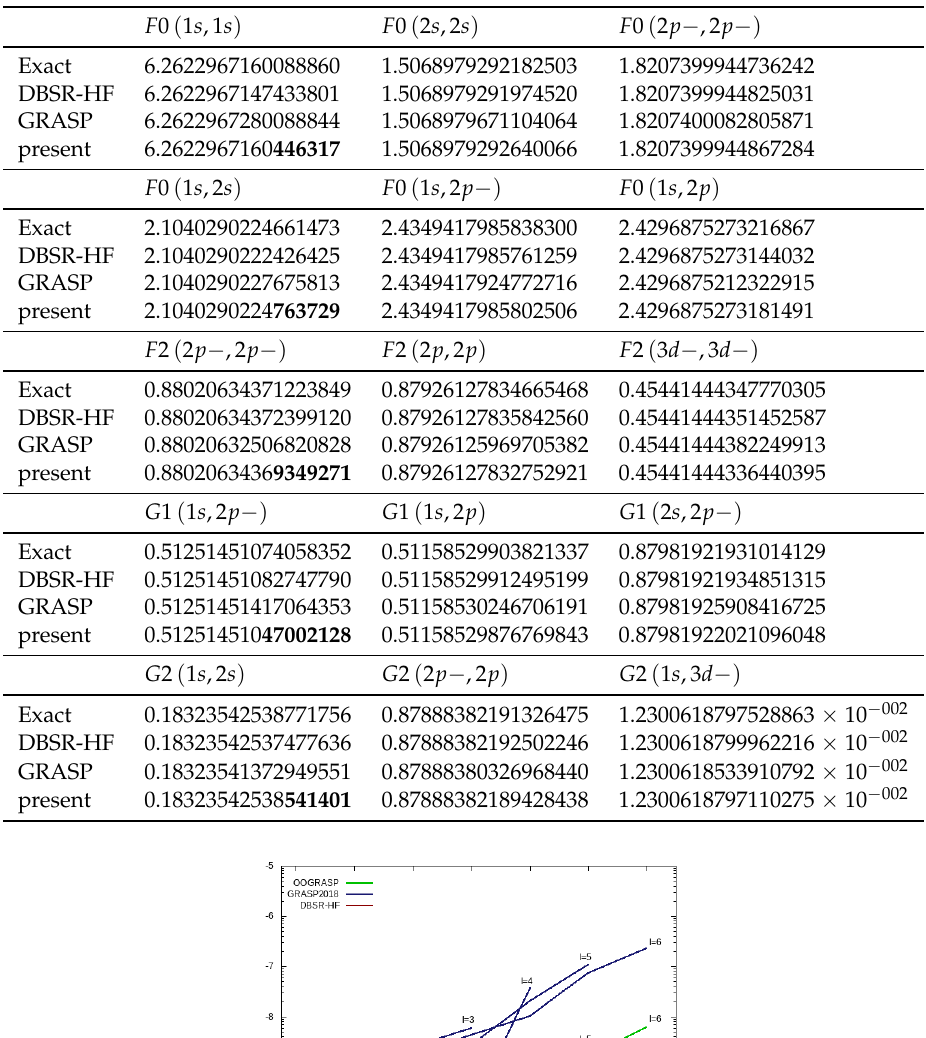
Table 5. Errors in present Slater integral values for Z = 10 hydrogenic functions compared with GRASP2018 and DBSR-HF. For present results, some digits in boldface are digits that differ from exact values.